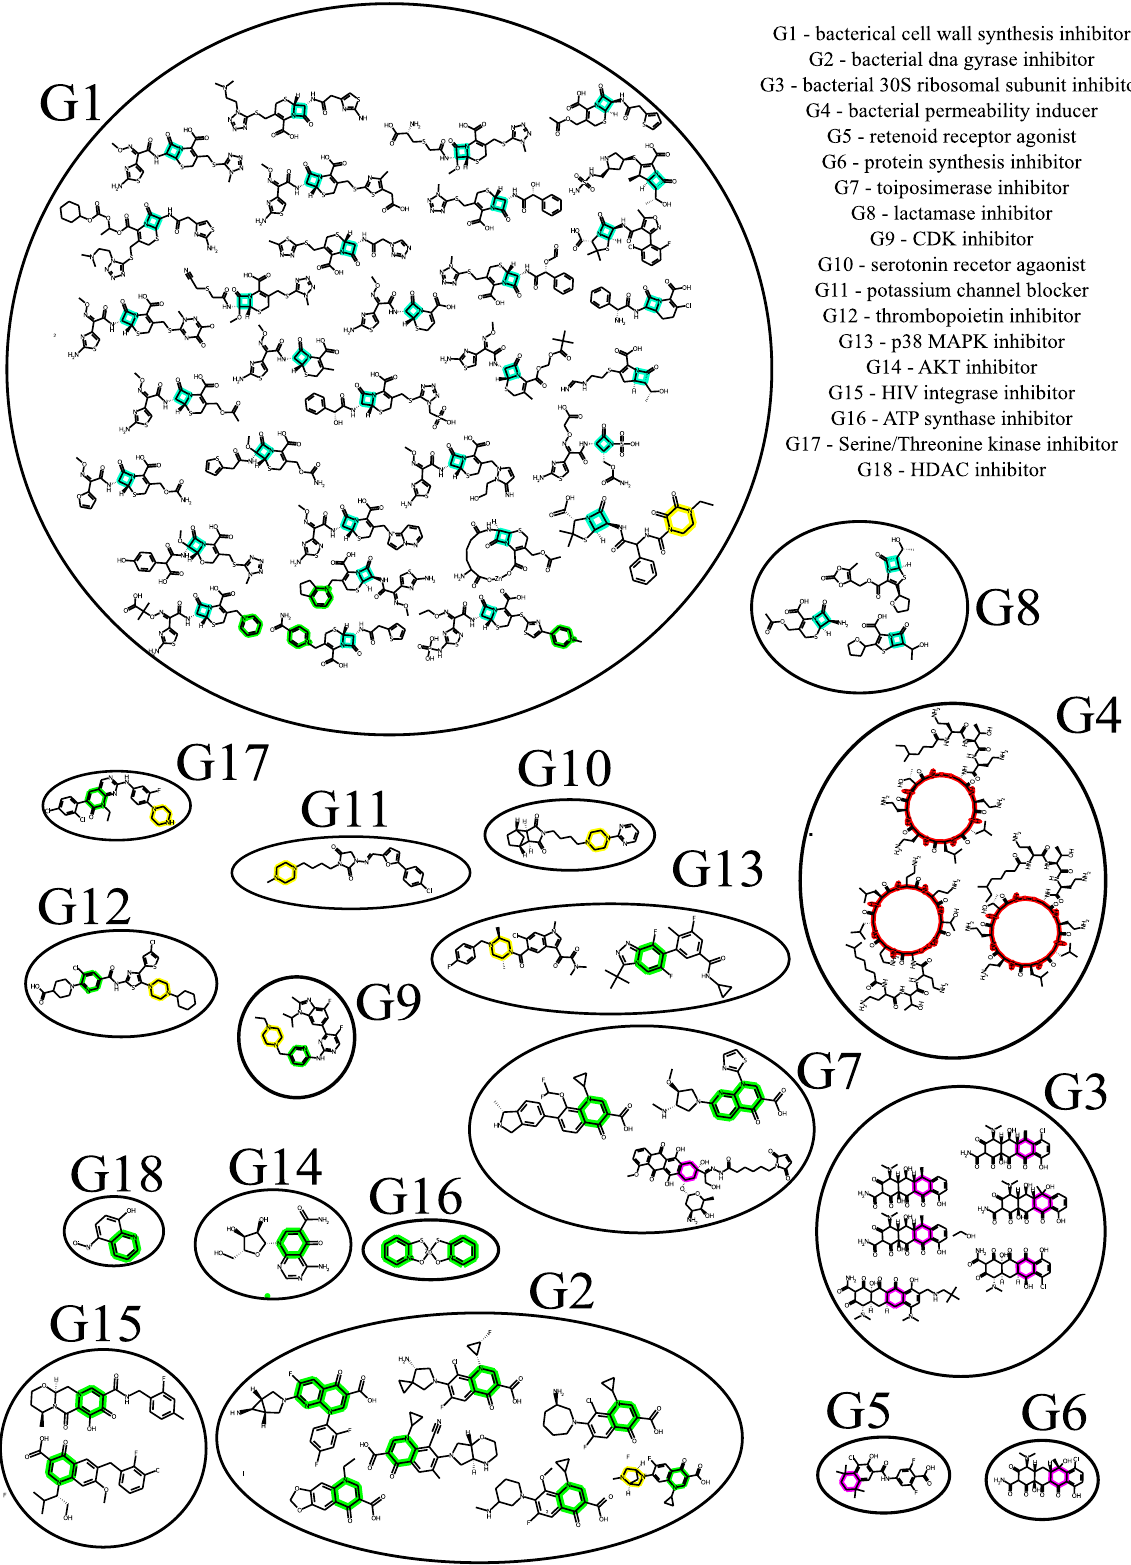
Figure 5. Mechanism of action of molecules containing at least one of the five most important simple rings according to the logistic regression model. Each of the five rings are highlighted with a different color. Molecules sharing the same mechanism of action, as reported in the Drug Repurposing Hub, are further circled together. For the majority of molecules with similar bioactive moiety, the mode of action is the